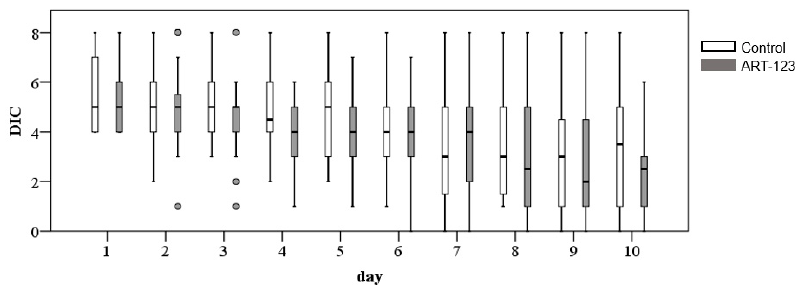
Figure 3. Changes of time course in DIC scores from day 1 to day 10.